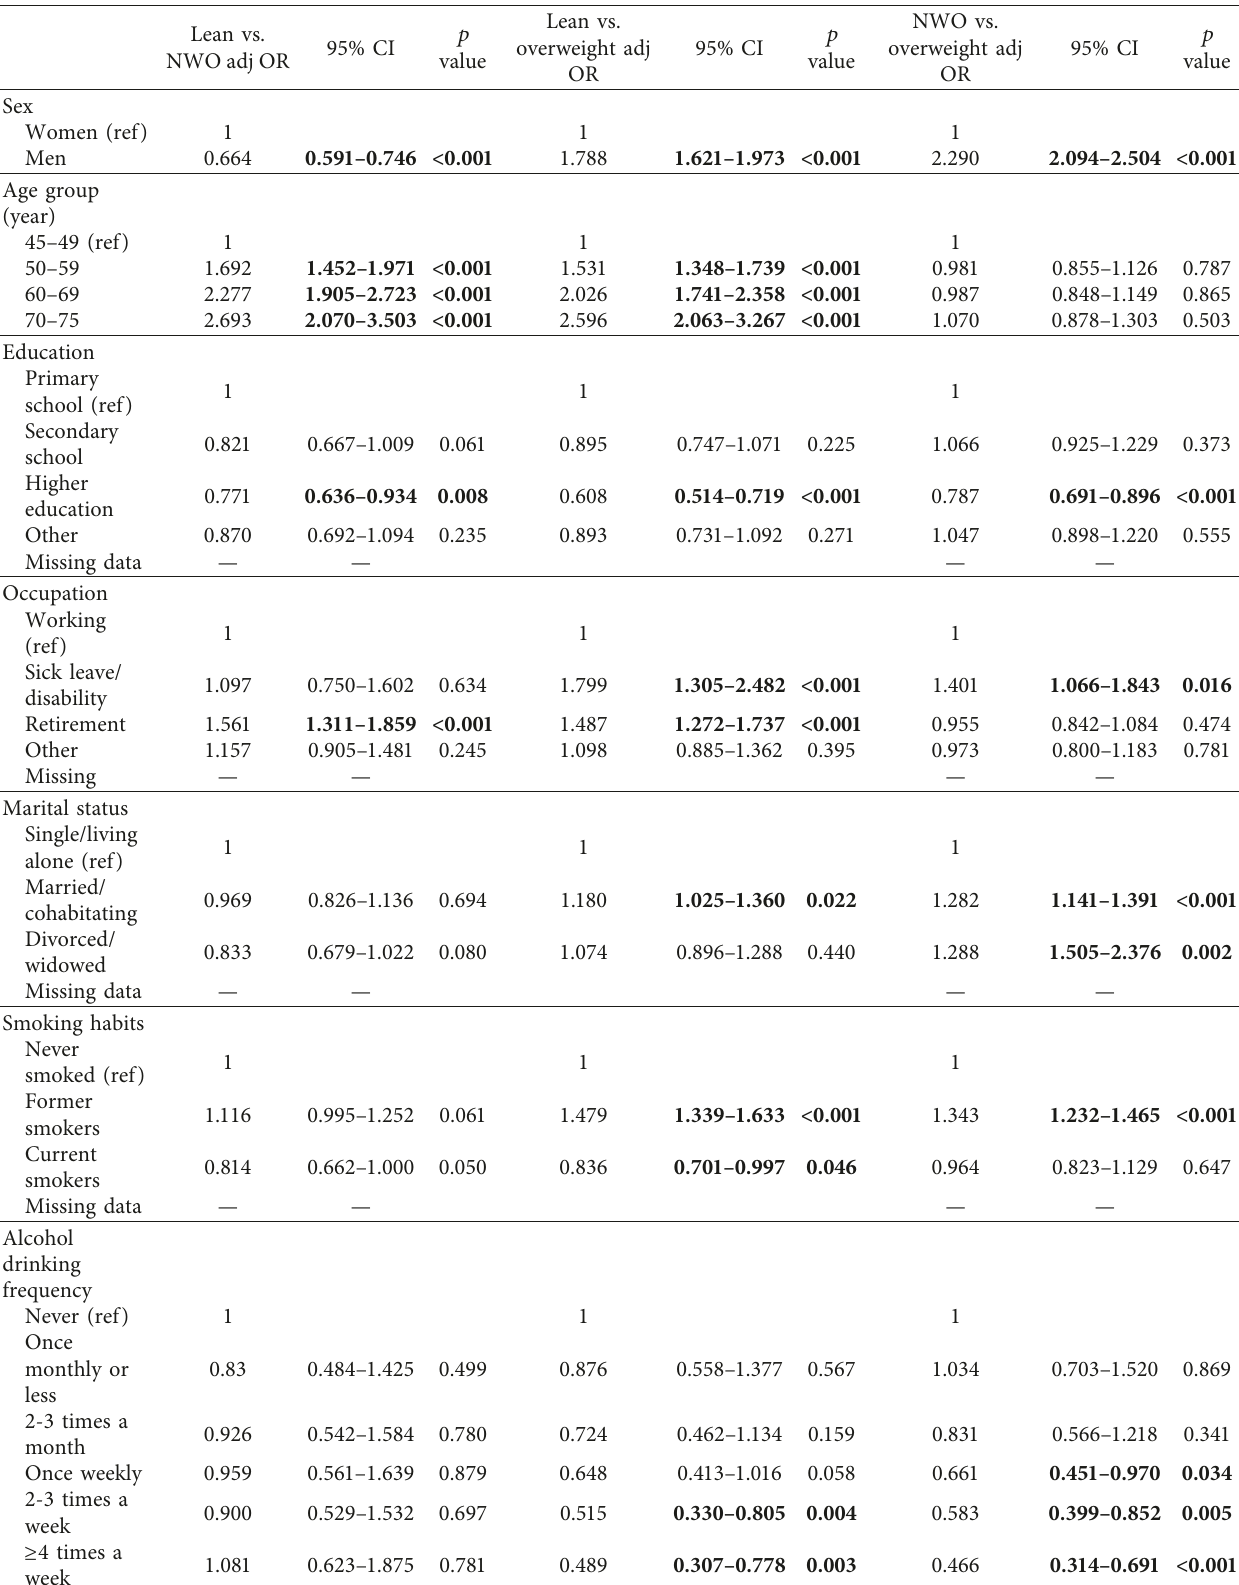
Table 3: Associations between lean, normal-weight obesity, and overweight with sociodemographic factors and smoking and alcohol habits in the EpiHealth